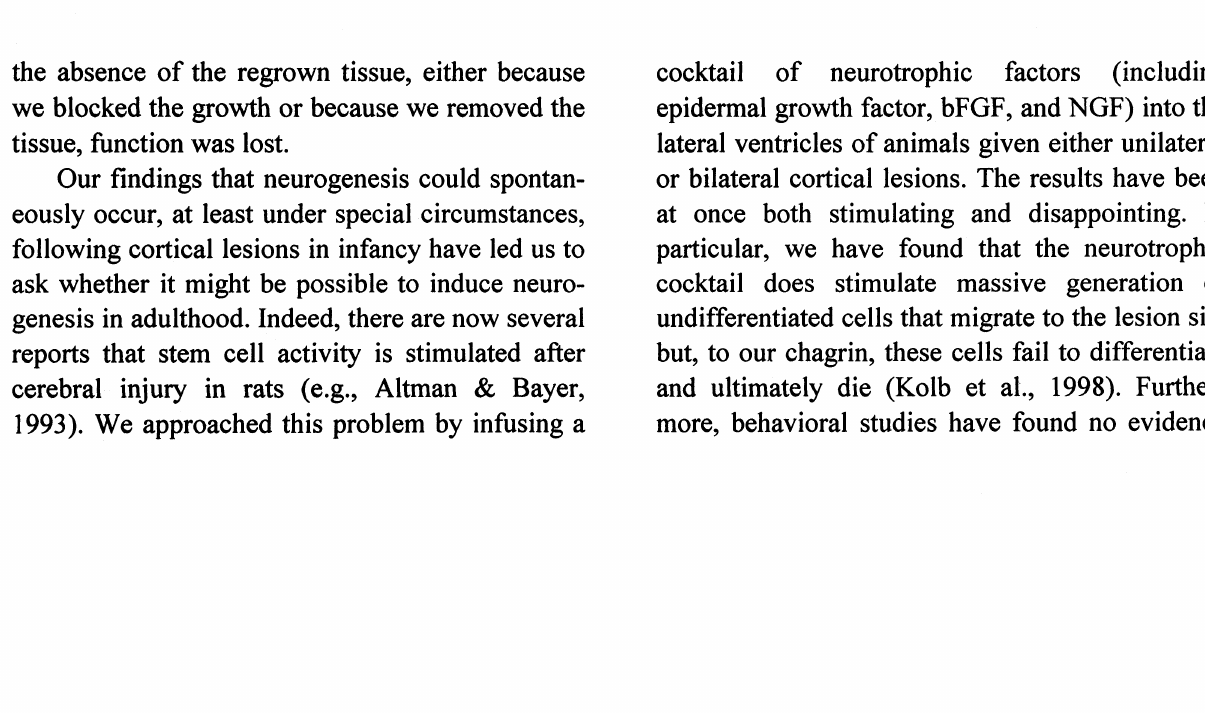
the absence of the regrown tissue, either because we blocked the growth or because we removed the tissue, function was